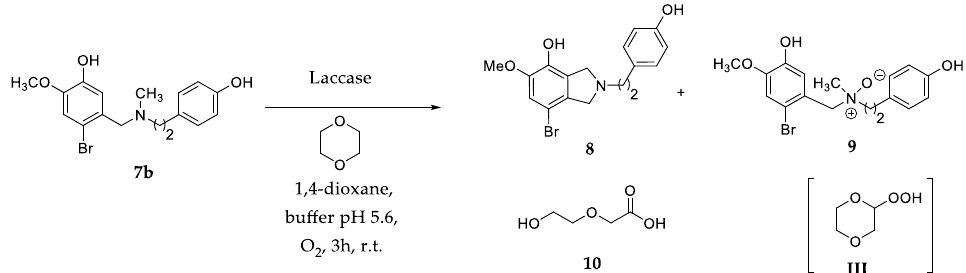
Scheme 1. Synthesis of belladine N -oxide derivative 9 from 7b. Isoindoline 8 and 2-(2-hydroxyethoxy)acetic acid 10 were isolated as by-products.